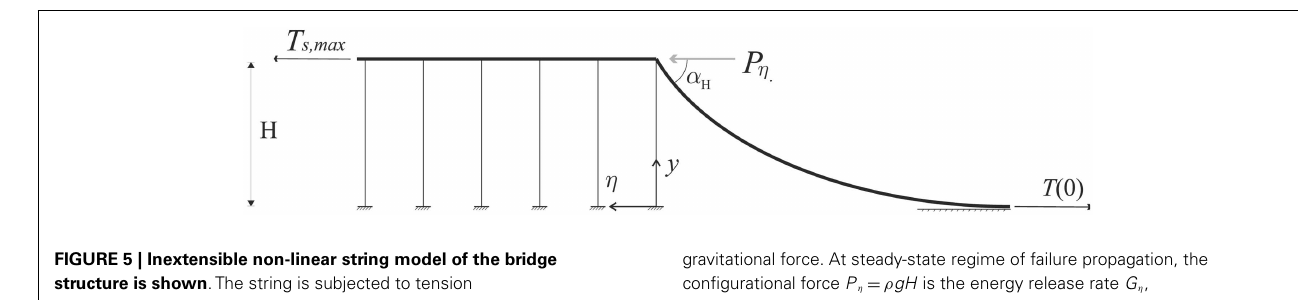
FIGURE 5 | Inextensible non-linear string model of the bridge structure is shown .The string is subjected to tension T ( y ) = T (0) + ρ gy , where ρ is the linear density and g is the